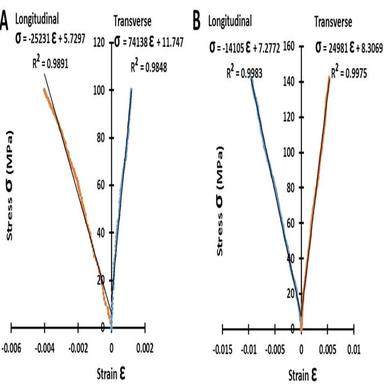
Typical raw compressive stress vs. strain graphs from DIC plus a mechanical tester. (A) Type A configuration, (B) Type B configuration. Lines-of-best-fit equations are shown.